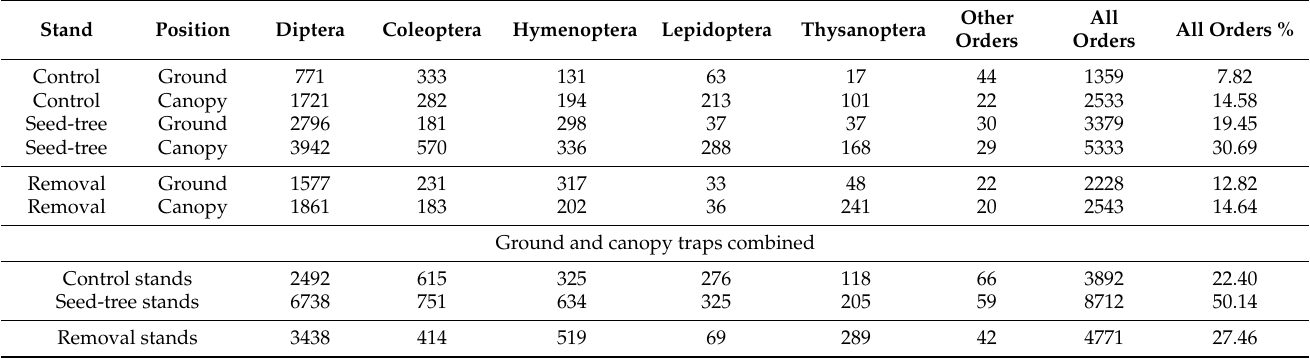
Table 1. The abundance of insects from different orders collected by two-year trapping in three different stand types of forest management (i.e., control, seed-tree, and removal) at two different trap positions (i.e., ground and